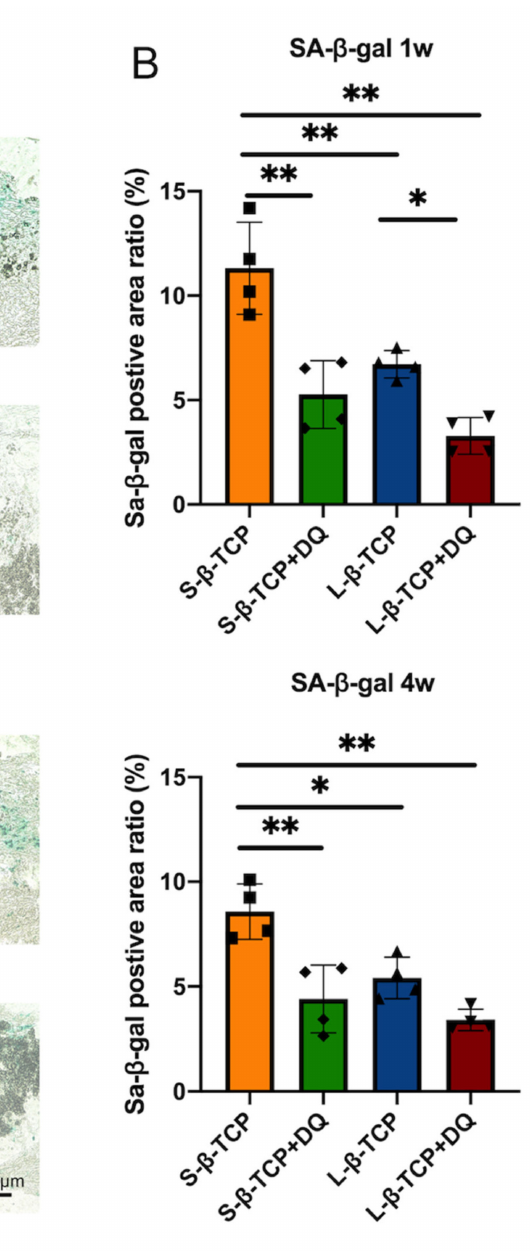
Figure 6. Identification of cellular senescence in bone defects at one week and four weeks after the operation. ( A ) SA- β -gal staining images of bone defects with or without DQ administration (scale bar = 100 µ m). Black triangles represent β -TCP granules; ( B ) SA- β -gal positive area ratio in the bone defect. Mean with SD ( n = 4). * p < 0.05, ** p < 0.01: One-way ANOVA analysis with Tukey–Kramer method as post hoc test. D: Dasatinib; Q: